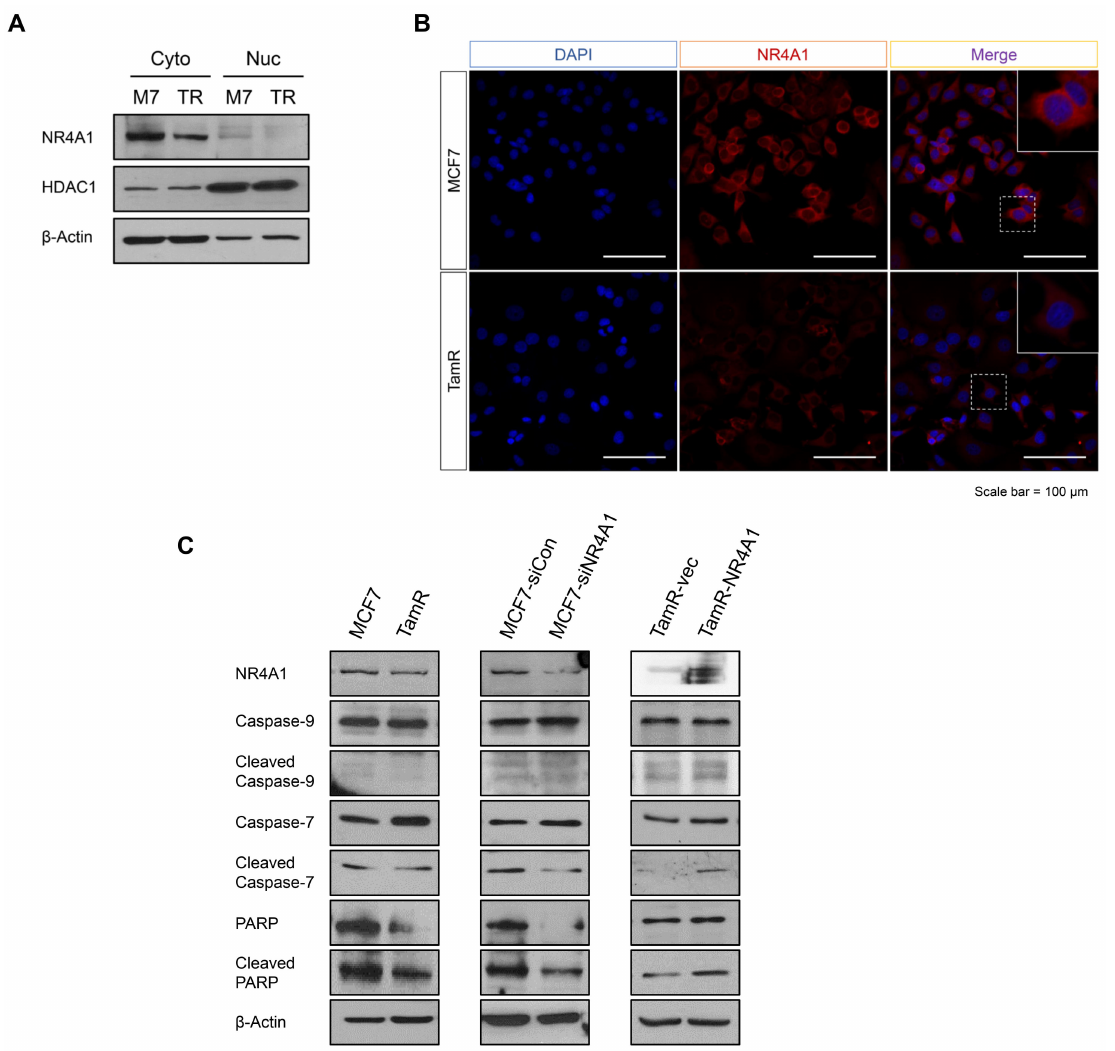
Figure 3. NR4A1 localized in the cytoplasm influences apoptosis. ( A ) Western blot analysis of cytoplasmic and nuclear NR4A1 proteins in MCF7 and TamR cells. ( B ) Representative images of immunofluorescence for NR4A1 localization in MCF7 and TamR cells. Scale bar = 100 µ m. ( C ) Western blot analysis for apoptosis-related proteins in MCF7, TamR, MCF7 cells transfected with scramble (negative) control (siCon), NR4A1 siRNA (siNR4A1), and TamR cells transfected with pcDNA3 and